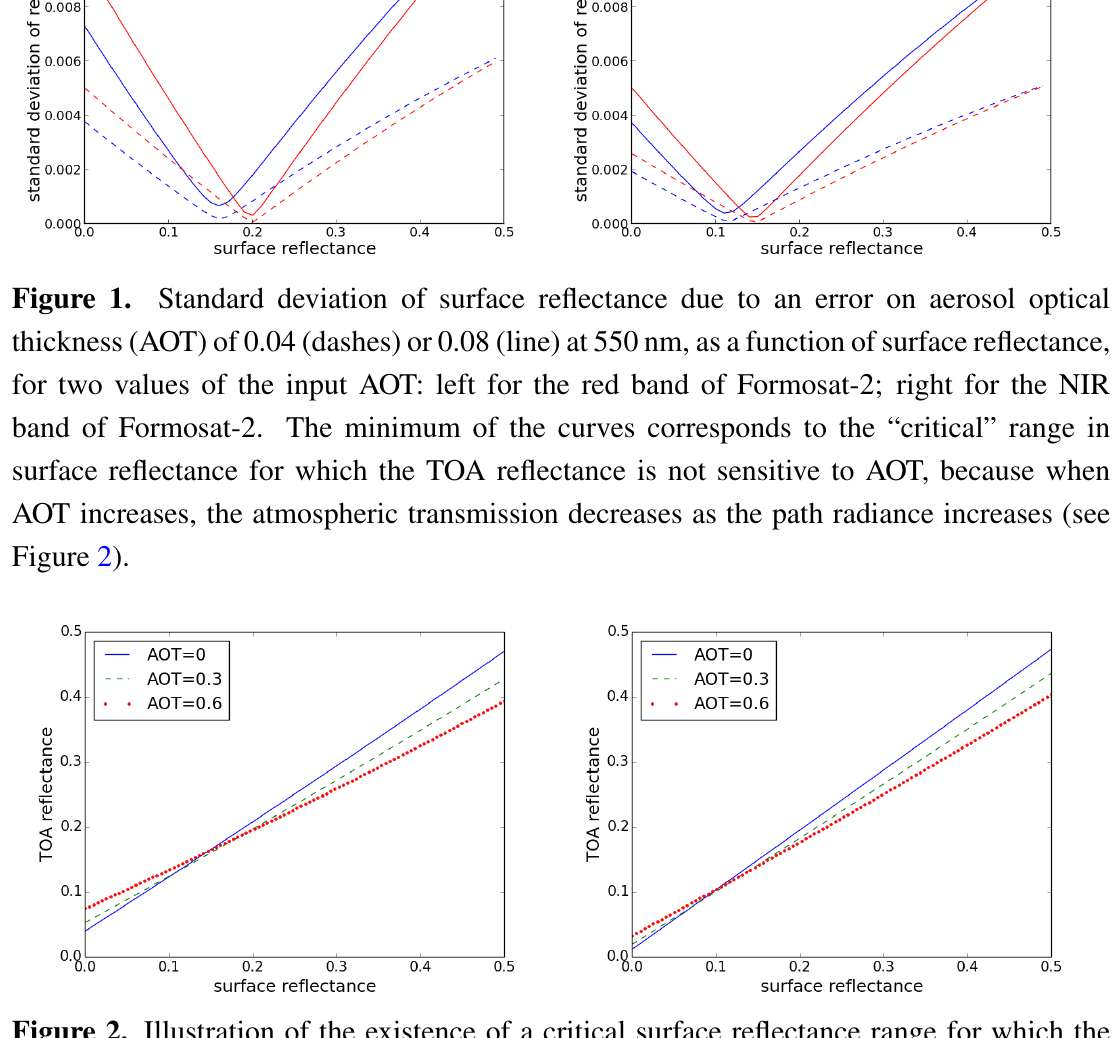
Figure 2. Illustration of the existence of a critical surface reflectance range for which the TOA reflectance nearly does not depend on the AOT: left for the red band of Formosat-2; right for the NIR band of